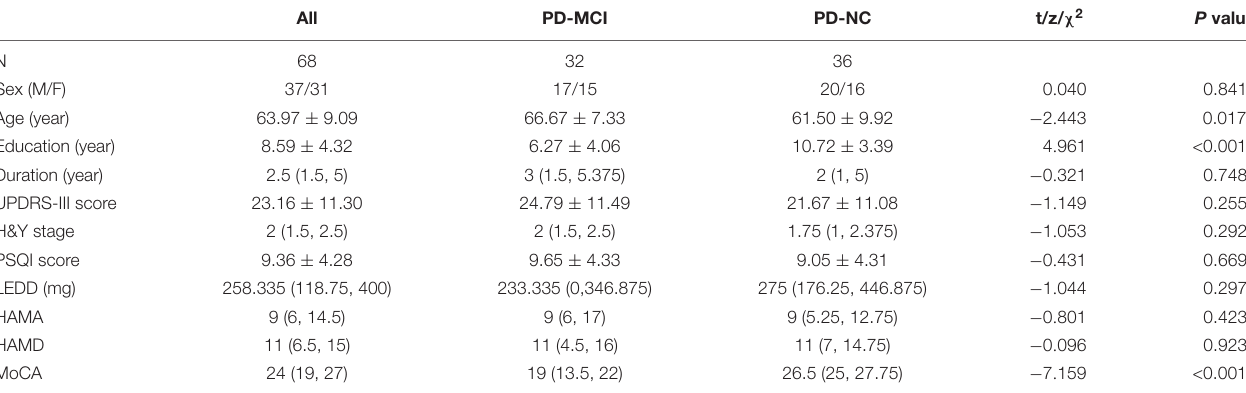
TABLE 1 | Main demographic and clinical characteristics in each